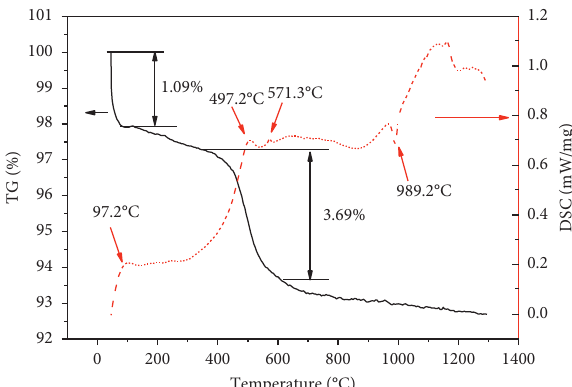
Figure 3: Thermal decomposition behavior of the